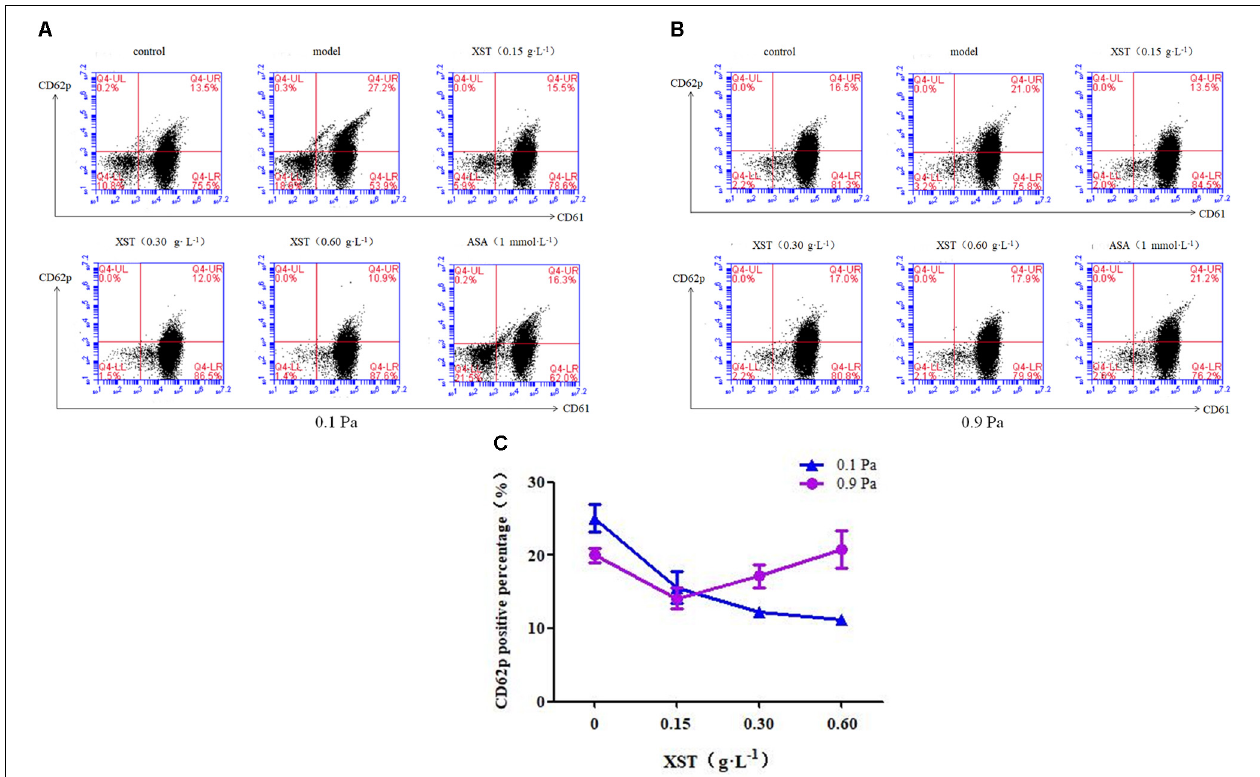
FIGURE 2 | Comparisons of platelets activation between groups. Representative scatter diagrams showing platelet CD62p expression (A) under 0.1 Pa flow condition, and (B) under 0.9 Pa flow condition. (C) Comparison of CD62p positive percentage between groups under different flow conditions. The percentages of CD61 + CD62p + platelets are depicted in the upper right quadrants of the contour plots, the CD61 + CD62p − and the CD61 − CD62p + platelets are depicted in the lower right and upper left quadrants, respectively, and CD61 − CD62p − platelets are depicted in the lower left quadrants. The data was presented as means ± SD, n = 3; data was analyzed by two-way ANOVA as described in Methods; analysis of simple effects.